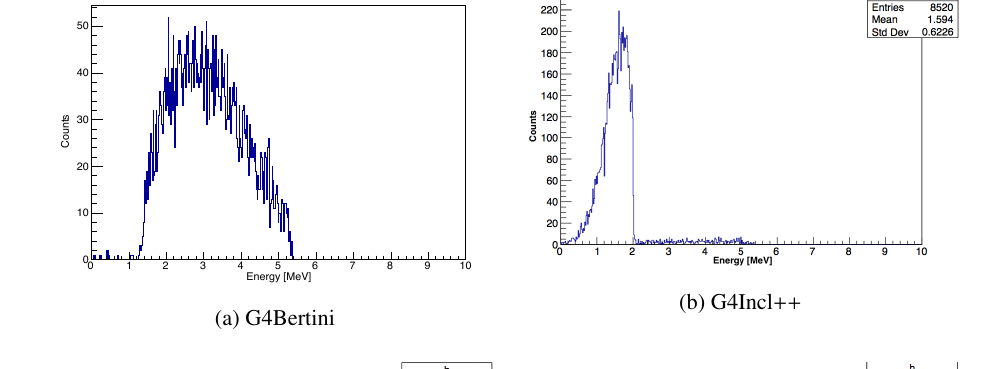
this reaction for α energy lower than 3.4 MeV down to 0.7 MeV which covering the reaction Gamow window of ν p -process relevance ( T 9 = 1 − 1 . 5). In this paper, we report the